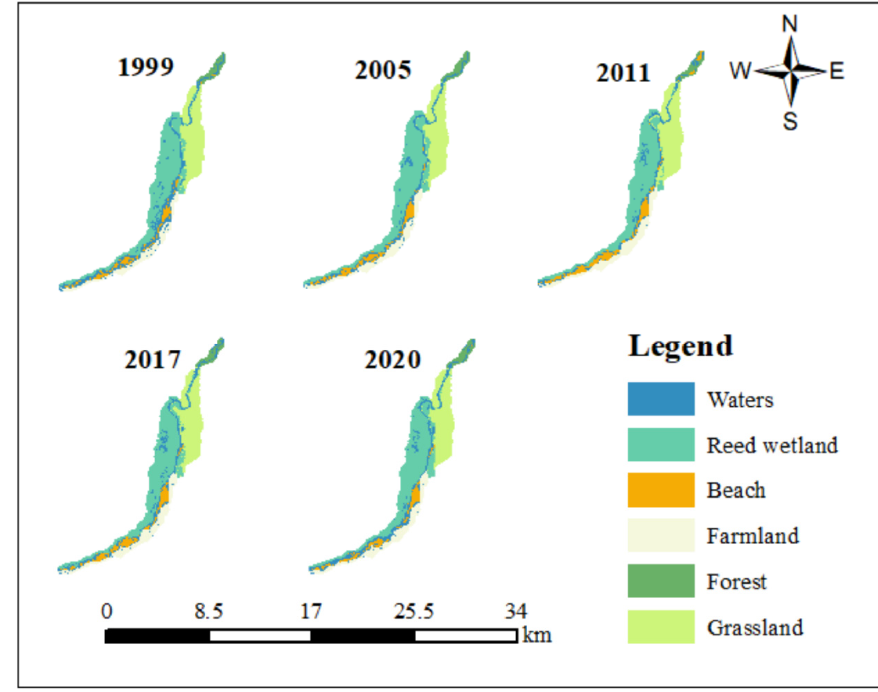
Figure 2. Spatial distribution map of land use from 1999 to 2020.